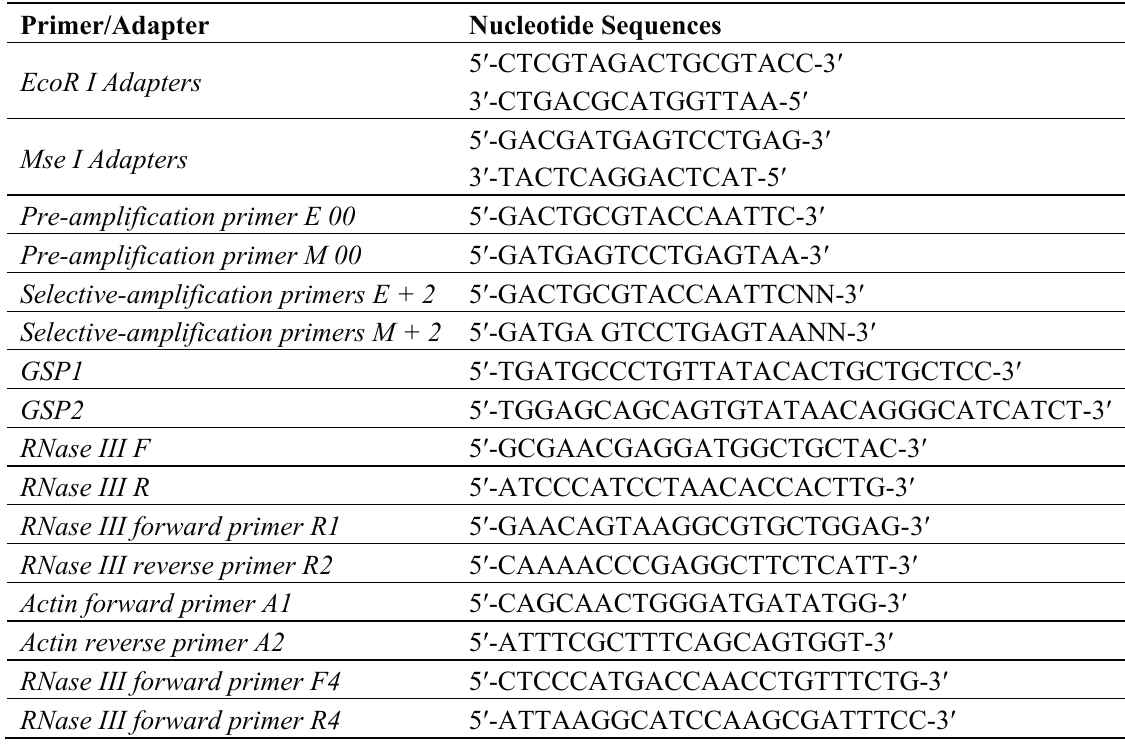
Table 1. Adapters and primers used in this